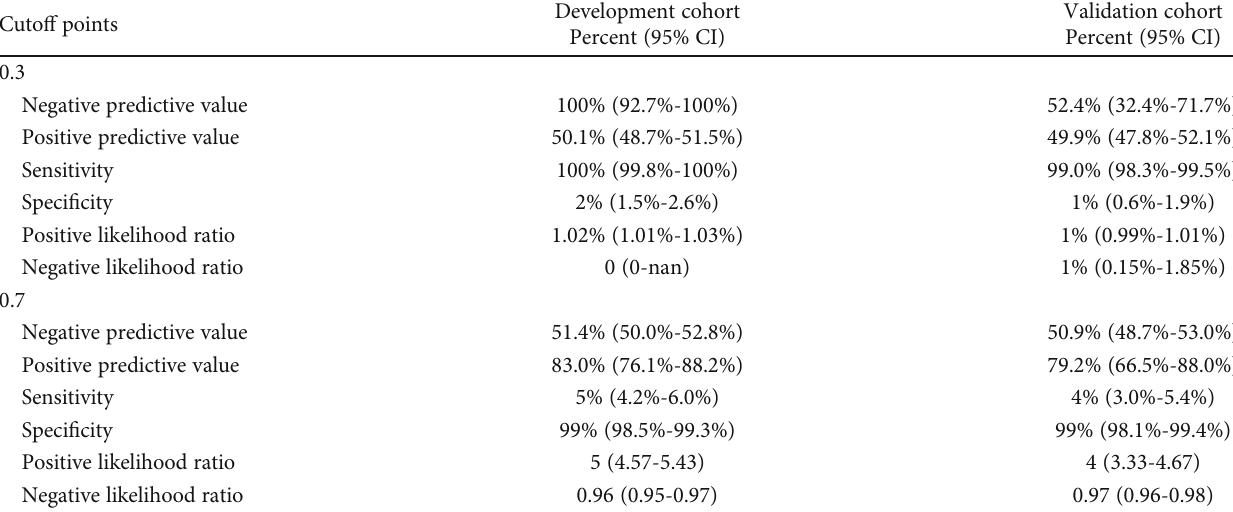
Table 3: Performance of the cuto ff points of 0.3 and 0.7 for the GBDT model in predicting adverse pregnancy